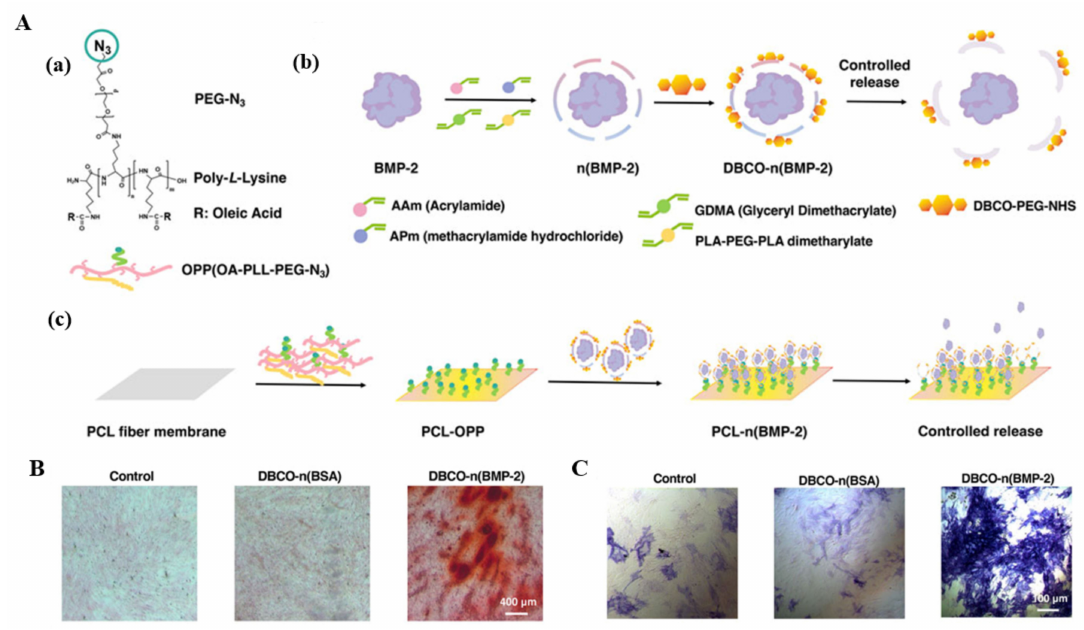
Figure 5. ( A ) (a) Schematic diagram of chemical structure of grafted polymer OA-PLL-PEG-N3 graft polymer; (b) Schematic of synthesis process about dibenzocyclooctyne-modified BMP-2